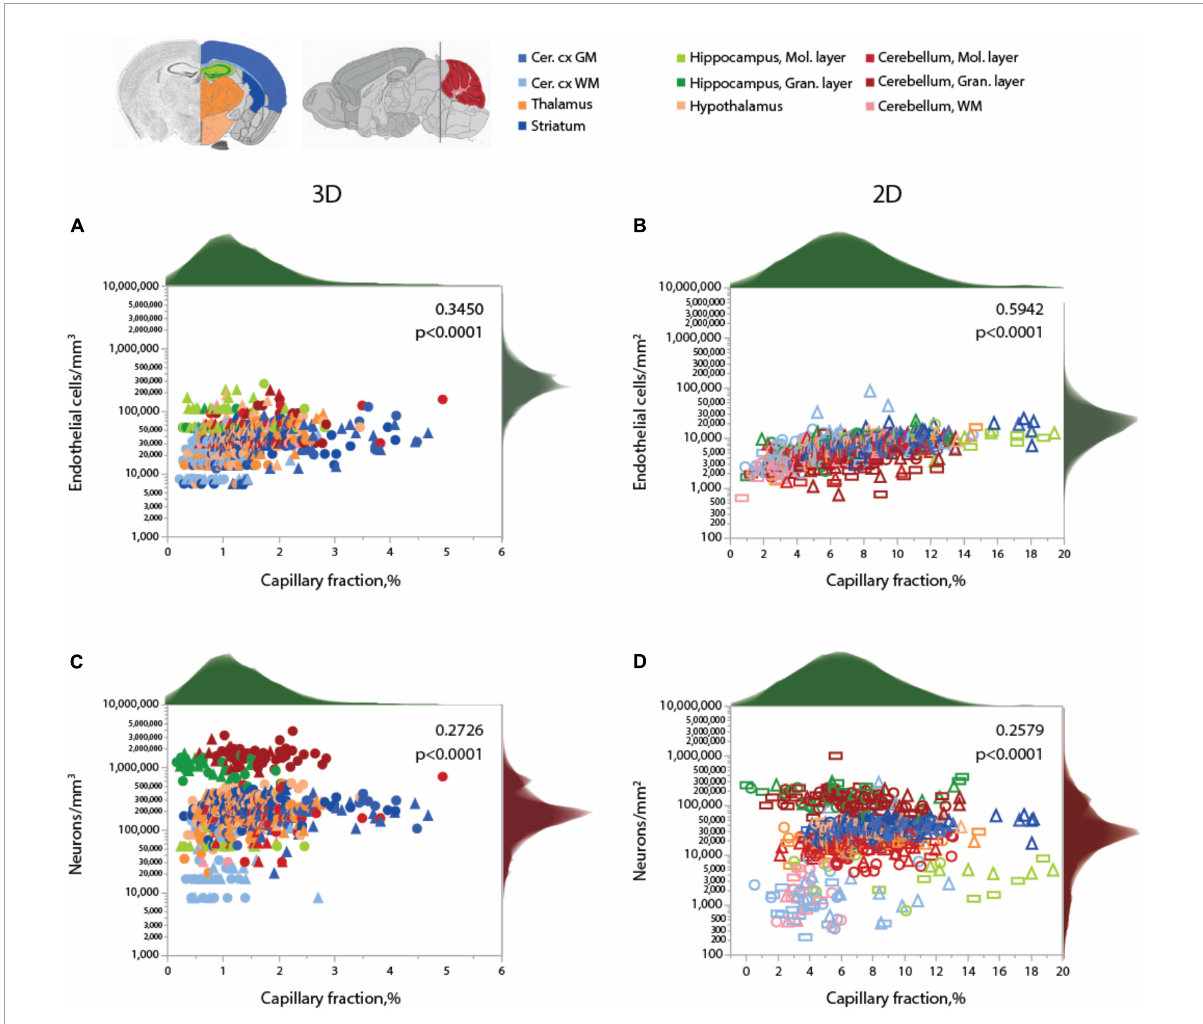
FIGURE4 Local capillary fraction correlates with local endothelial cell density, but not with neuronal cell density. (A,B) Local density of endothelial cells correlates with local vascular fraction across all sites and structures analyzed in 3D ( A ; two animals, shown in circles or triangles, left) and in 2D (B) ; three animals, shown in circles, triangles, or rectangles, right) with the Spearman correlation coefficients and p -values across all animals and sites indicated in each graph. (C,D) In contrast, local neuronal density does not correlate significantly with local vascular fraction across brain sites and structures in 3D (C) or in 2D (D) . Histograms above and to the right reflect the distribution of all data points in each axis. Graphs in (A,C) and (B,D) are shown with similar X and Y scales for comparison. Correlation coefficients and power exponents for each structure are given in Table 6